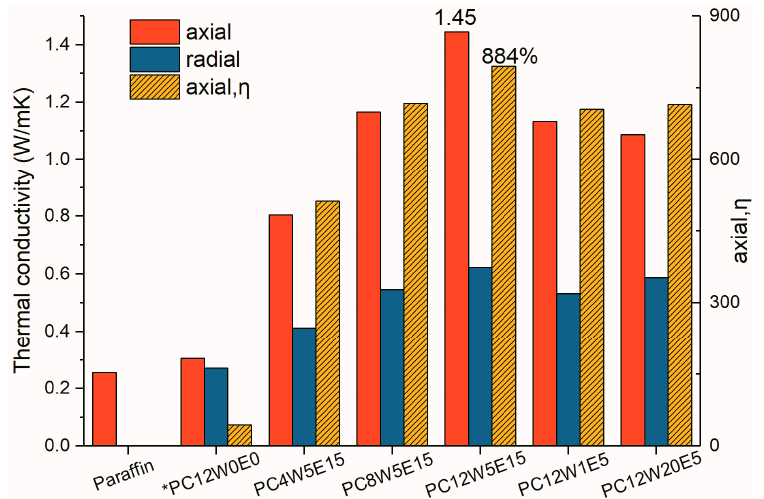
Figure 15. Thermal conductivity and thermal enhancement efficiency of AGA/paraffin composites (where * was prepared by non-heat flow method).